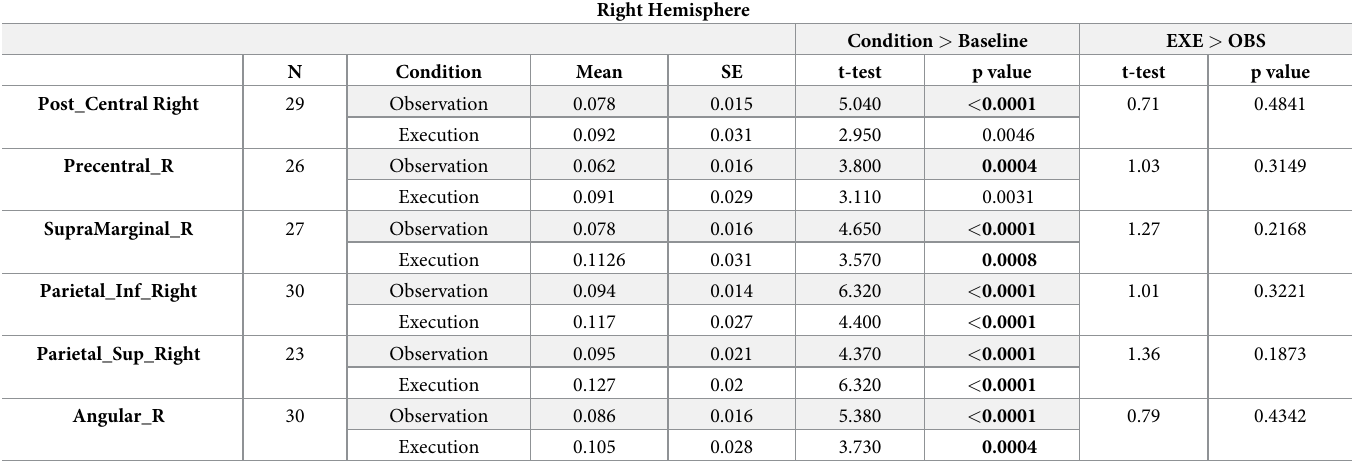
Table 2. HbO2 response to observation and execution conditions in regions of interest (ROI) in the right hemisphere.